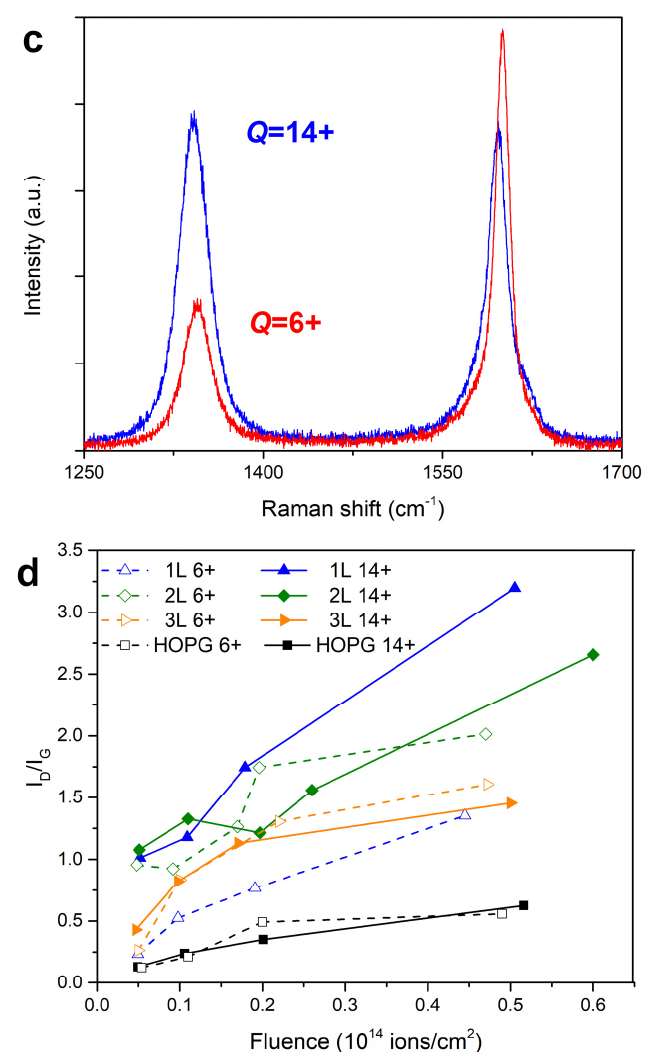
Figure 1. ( a ) Raman spectra of the monolayer graphene irradiated with 23 MeV iodine beam and charge state Q = 6+, with fluences between 5 × 10 12 and 5 × 10 13 ions/cm 2 . For comparison, a spectrum from unirradiated graphene is also added. ( b ) Raman spectra of the monolayer graphene irradiated with 23 MeV iodine beam and equilibrium charge state Q = 14+, with fluences between 5 × 10 12 and 5 × 10 13 ions/cm 2 . For comparison, a spectrum from unirradiated graphene is also added. ( c ) Com- parison of Raman spectra for monolayer graphene irradiated with 23 MeV I beam at the fluence of 5 × 10 12 ions/cm 2 with the charge state of Q = 6+ and Q = 14+. ( d ) Ratio of the peak intensities I D /I G as a function of the applied ion fluence and charge state Q for monolayer graphene (blue), bilayer graphene (green), trilayer graphene (orange), and HOPG (black).